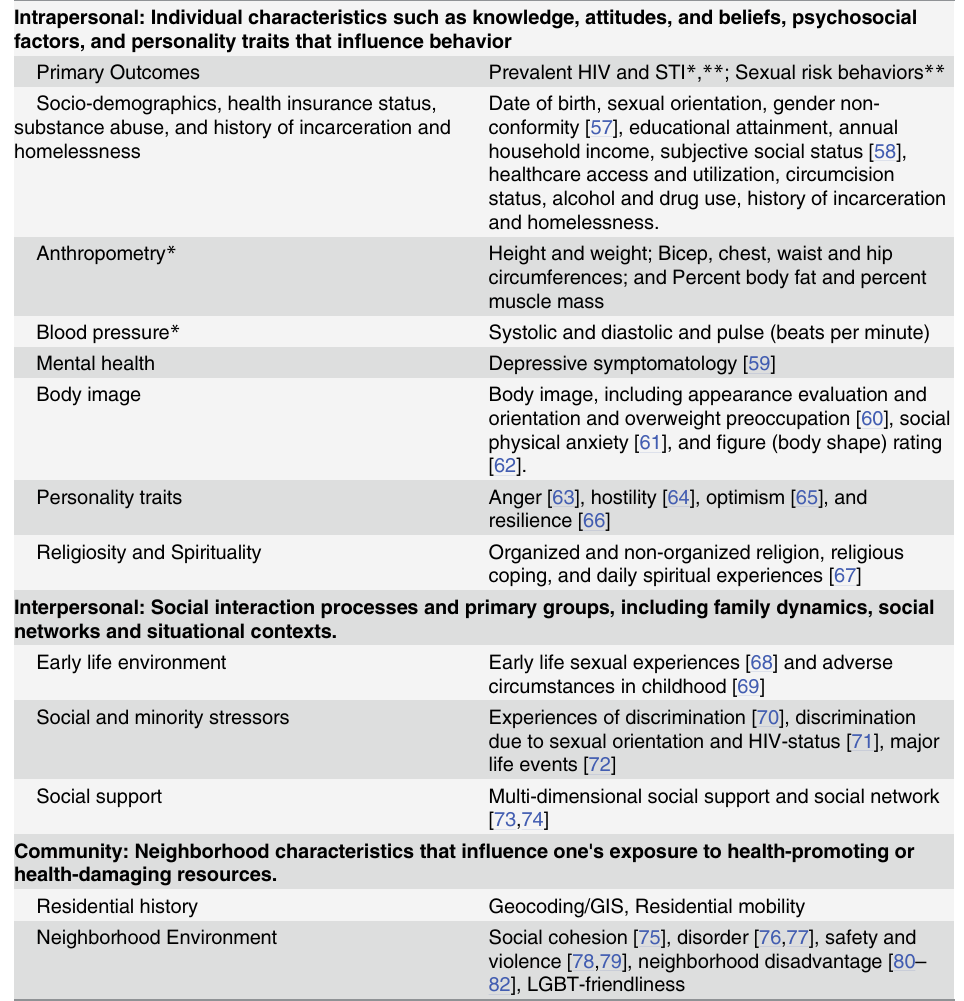
Table 2. A socio-ecological model perspective. Multi-level influences of HIV risk among African American MSM in The MARI Study.